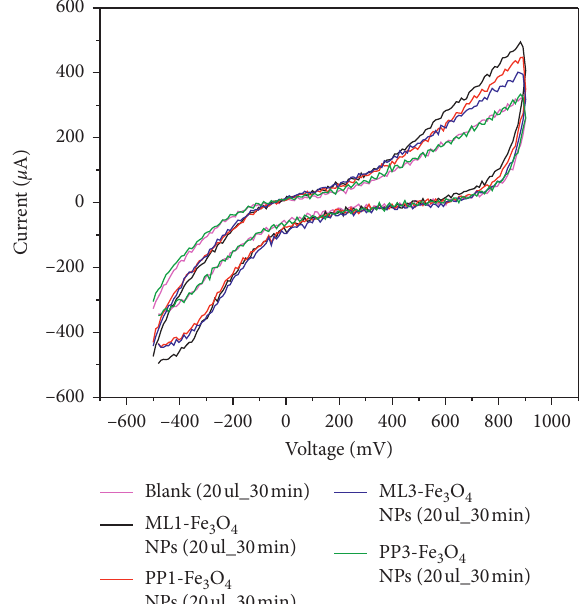
Figure 8: CV analysis plot after 20 μ l of sample suspension was